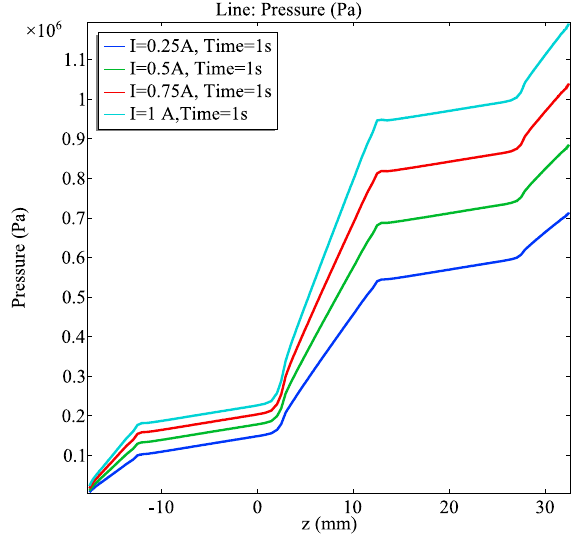
Figure 6. The pressure of damping gap at different currents for I = 0.25, 0.5, 0.75, and 1 A.